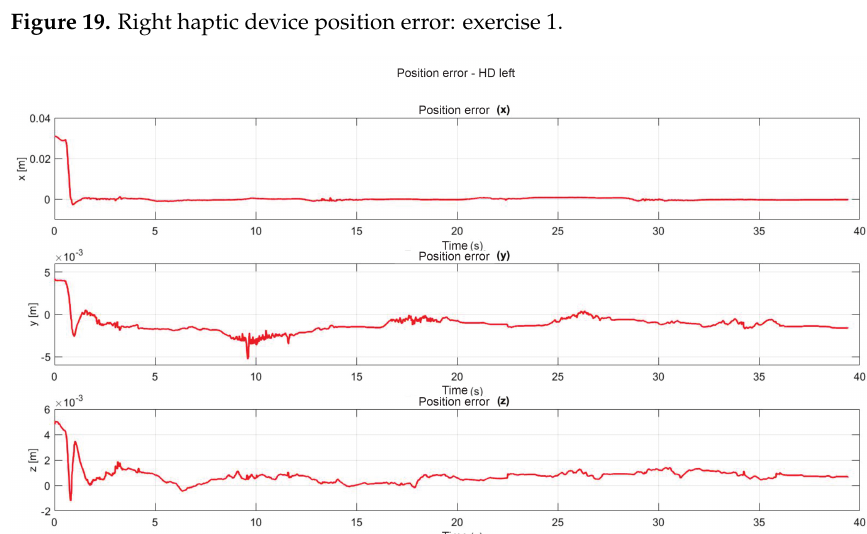
Figure 20. Left haptic device position error: exercise